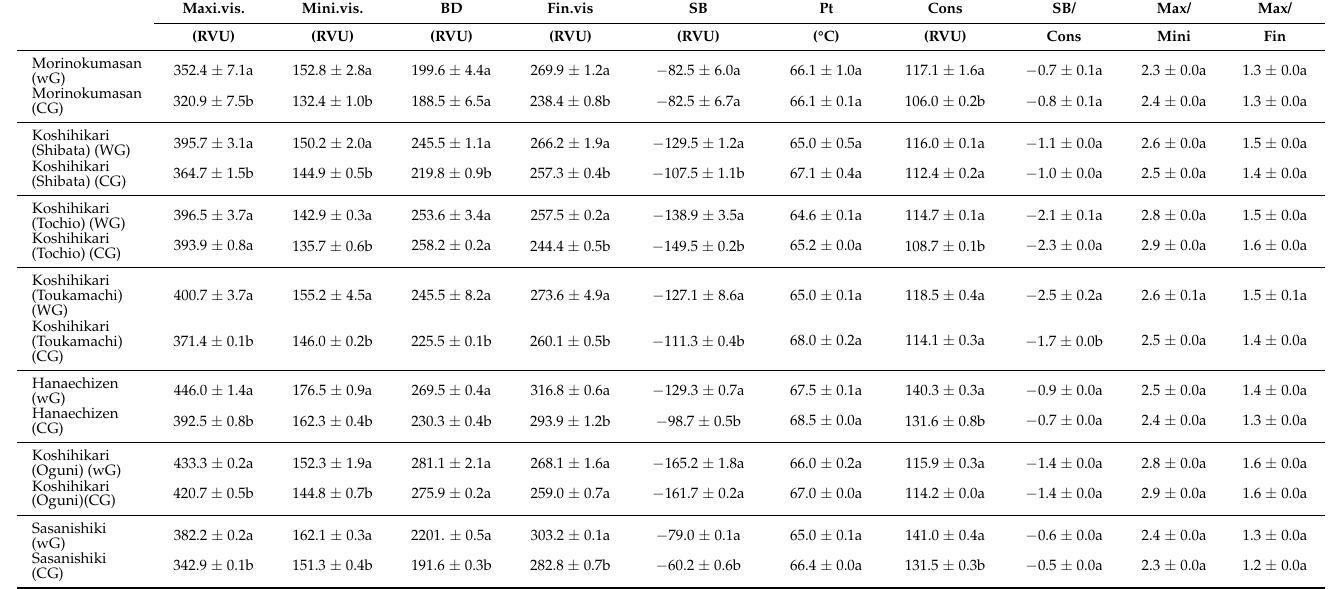
Within each measure (Max. vis, Mini. vis, etc.) in the same column and difference between whole grains and chalky grains in each sample, different letters (a, b, c, etc.) denote statistically significant differences. Abbreviation: SB, Setback (Final. Vis-Max. vis); BD, Break-down (Max. vis-Mini. vis); Max. vis, Maximum viscosity; Mini. vis, Minimum viscosity; Pt, Pasting temperature; Cons, Consistency (Fin. vis-Mini. vis); Fin. vis, Final. viscosity.